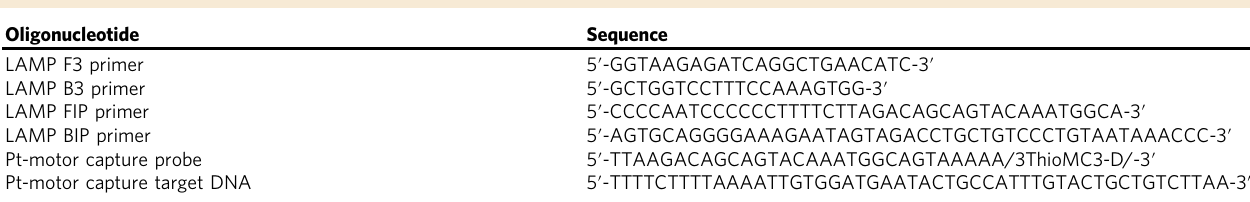
Table 1 List of DNA sequences used in this study Oligonucleotide Sequence LAMP F3